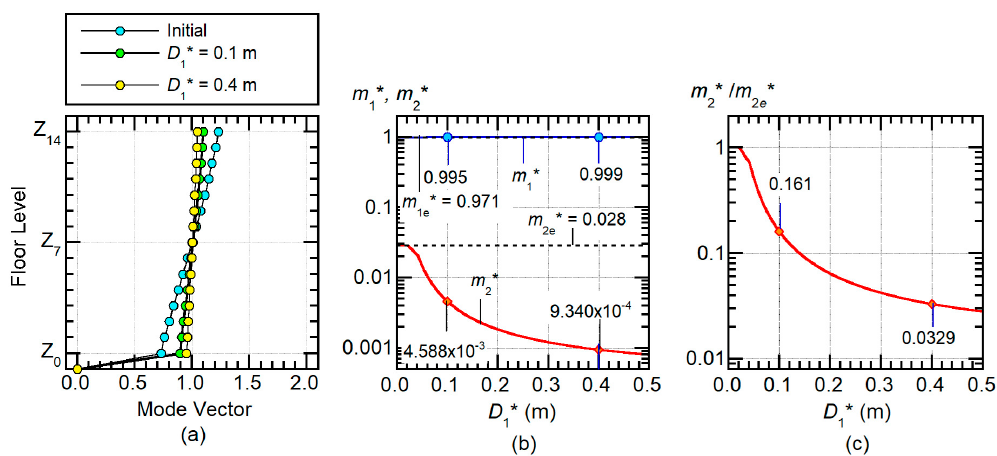
Figure 11. Influence of the mode shape change at each step: ( a ) variation of the first mode shape; ( b ) variation of the effective modal mass ratio for two modes; ( c ) variation of m 2* / m 2e* .